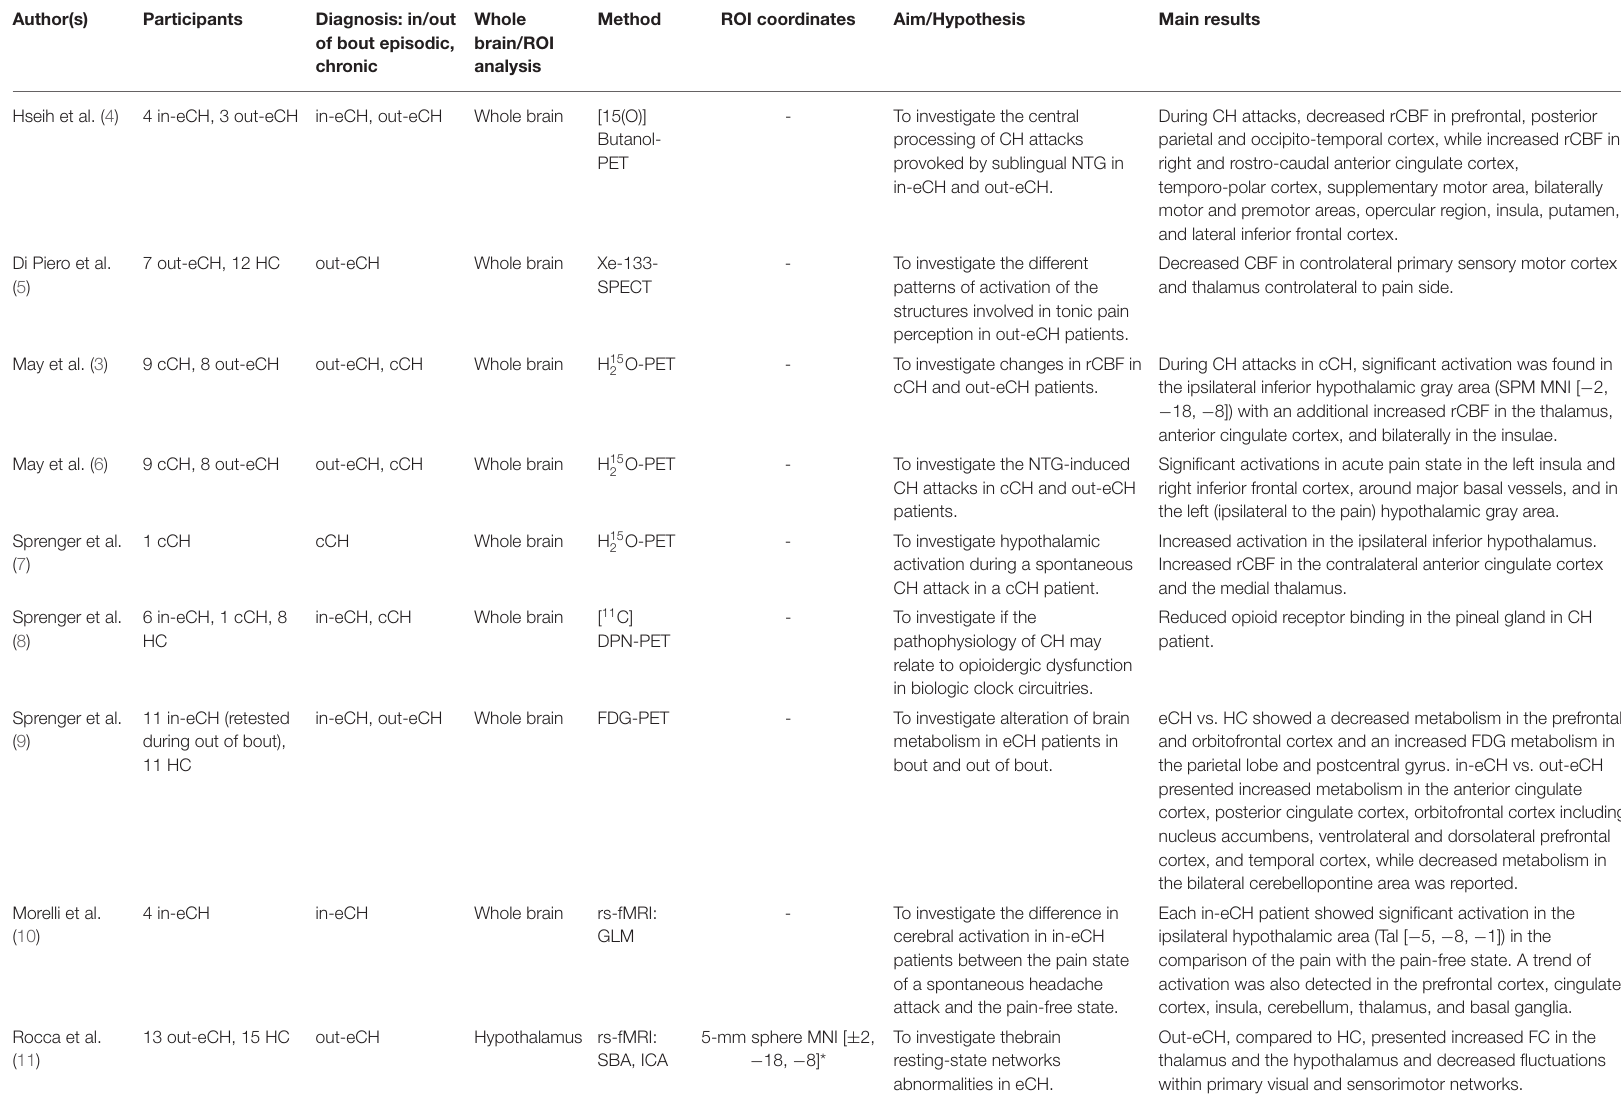
TABLE 1 | List of metabolic and functional studies on cluster headache.